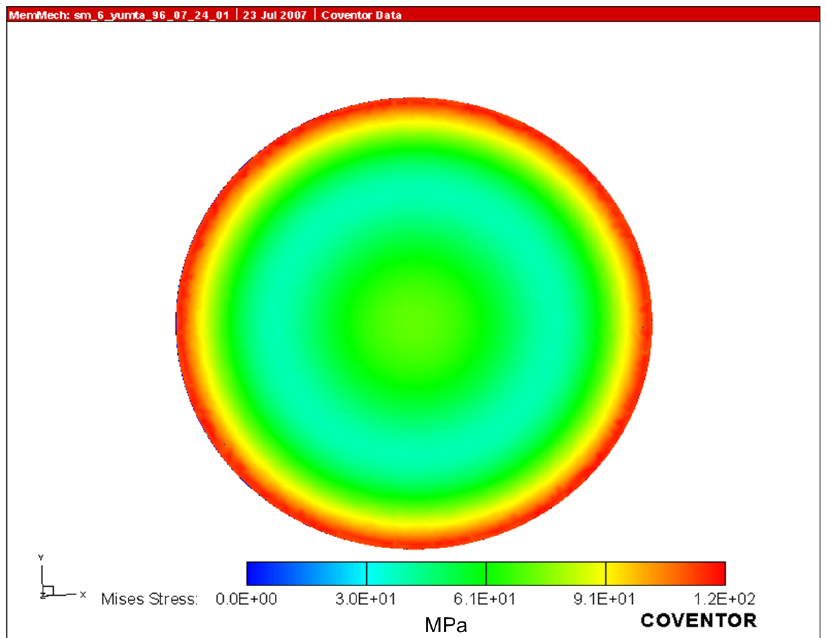
Figure 3. Stress distribution of the membrane.